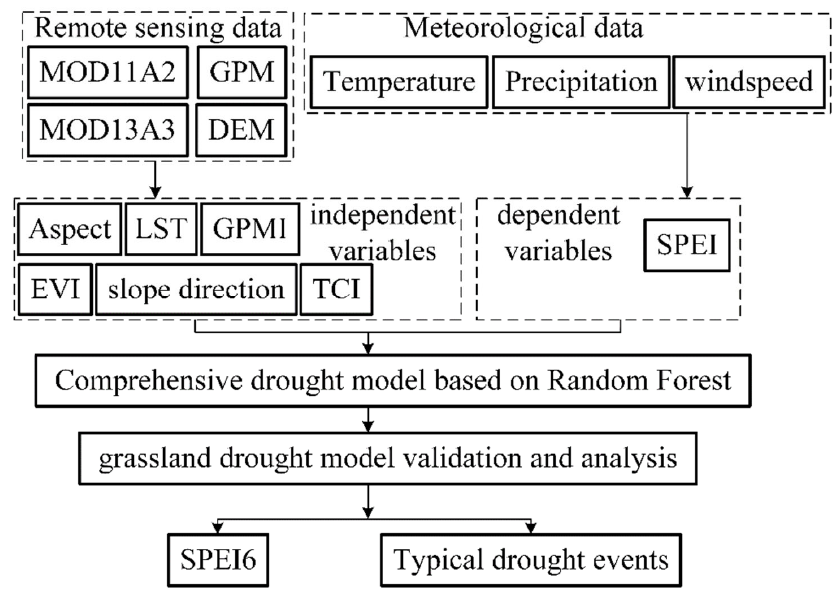
Figure 2. Grassland drought monitoring model construction.